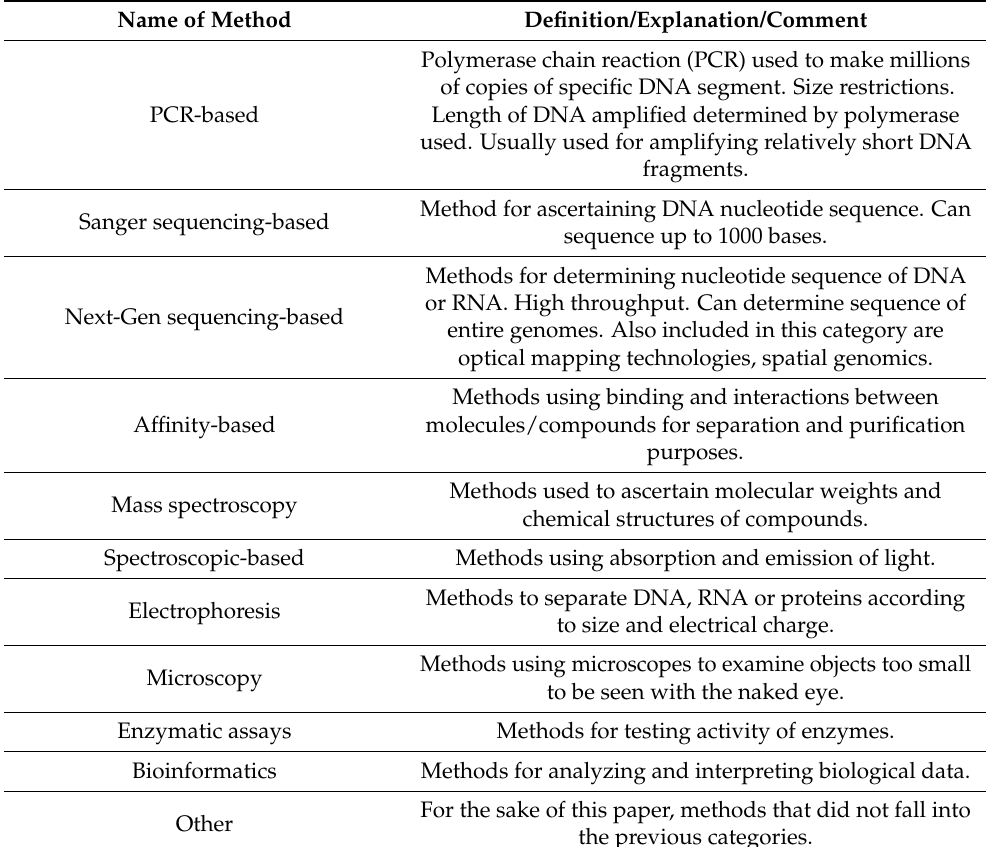
Table 2. Description of analytical